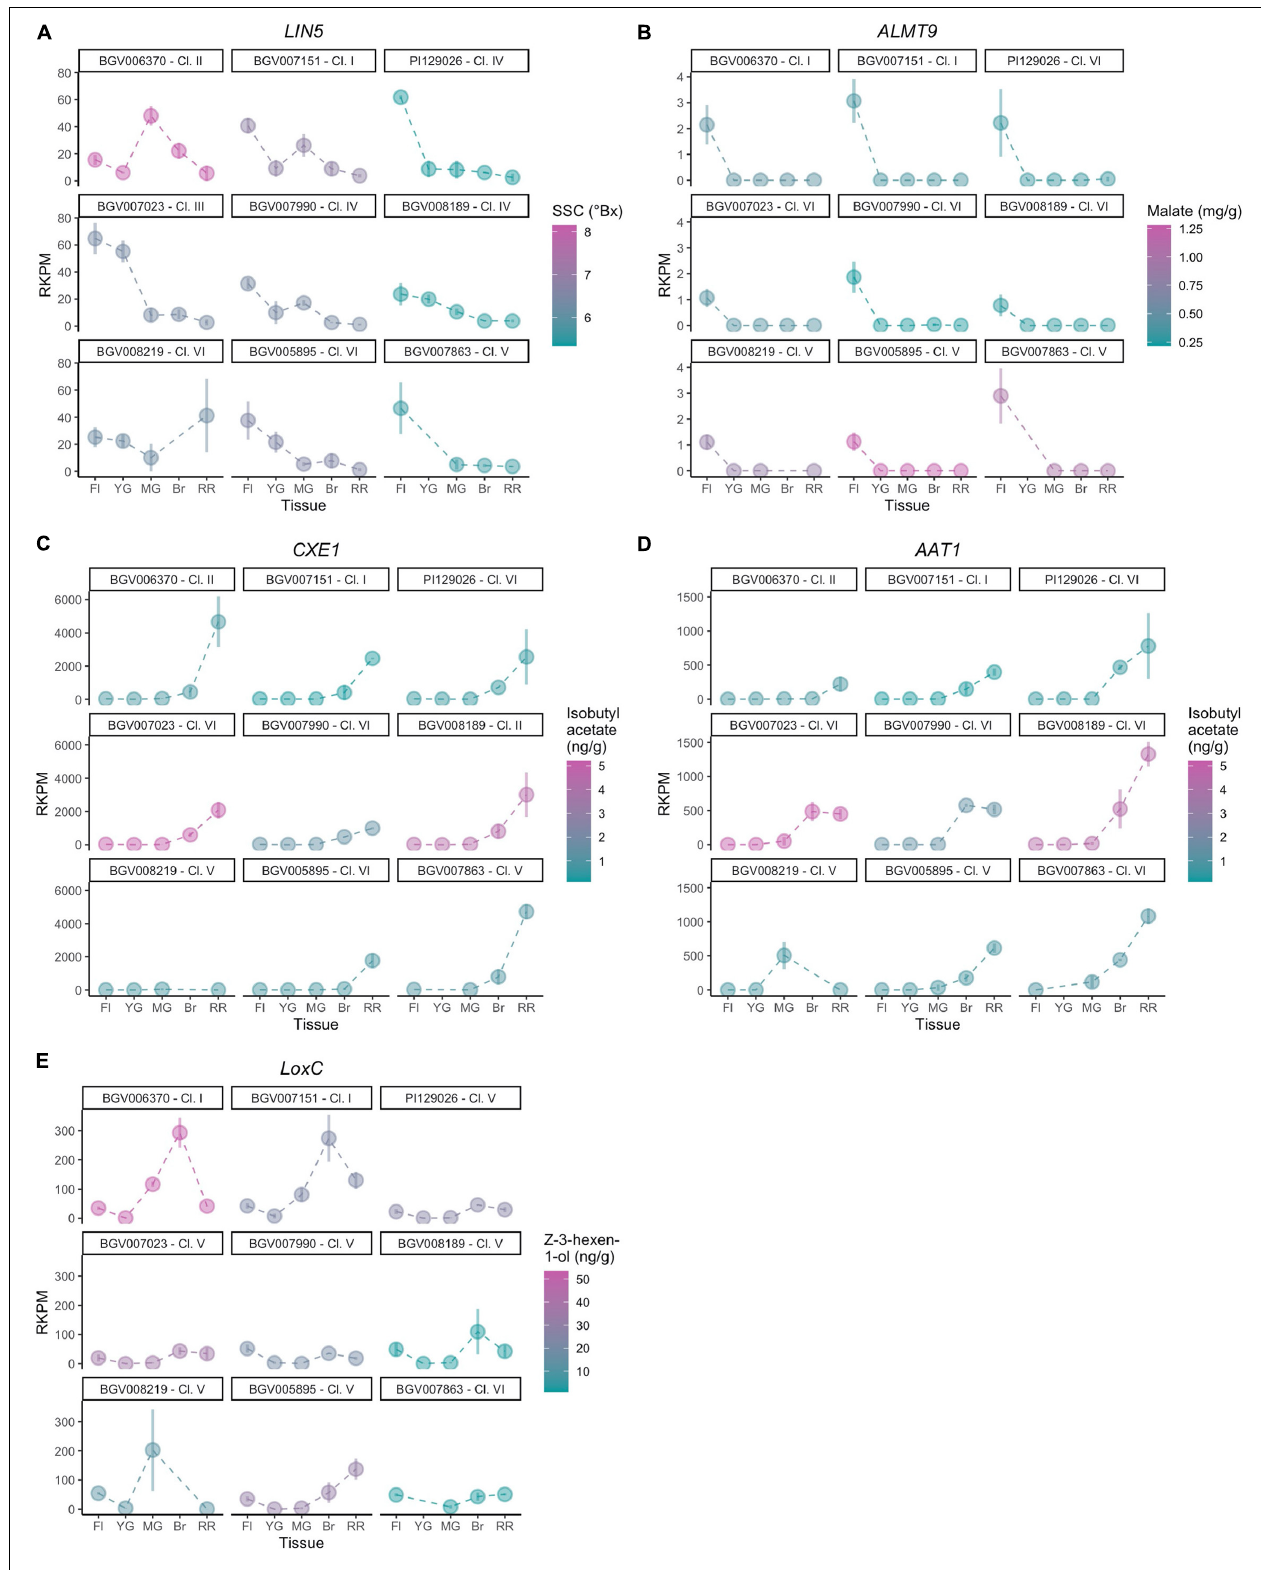
FIGURE 8 | (A–E) Gene expression of nine representative accessions for flavor-related genes.